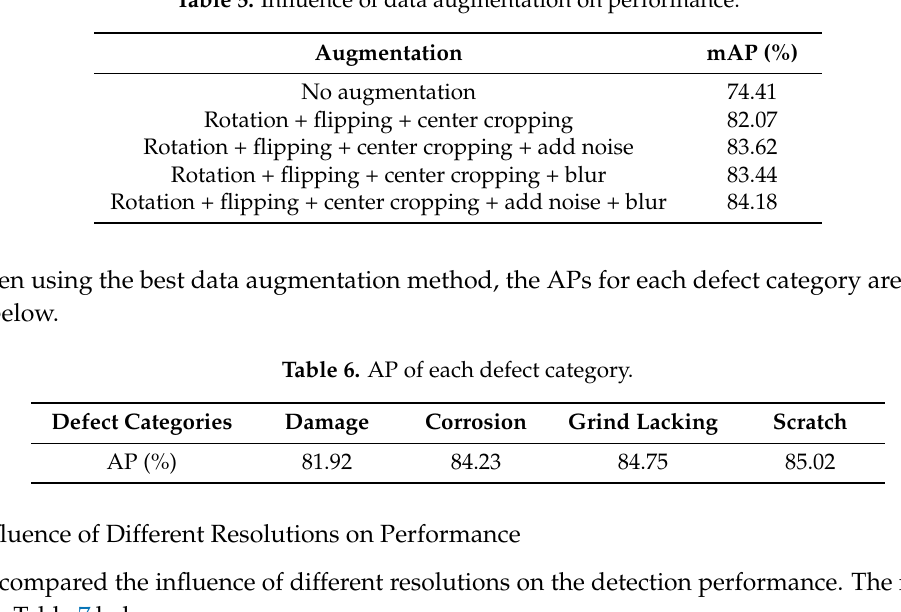
Table 7. Influence of different resolutions on performance.